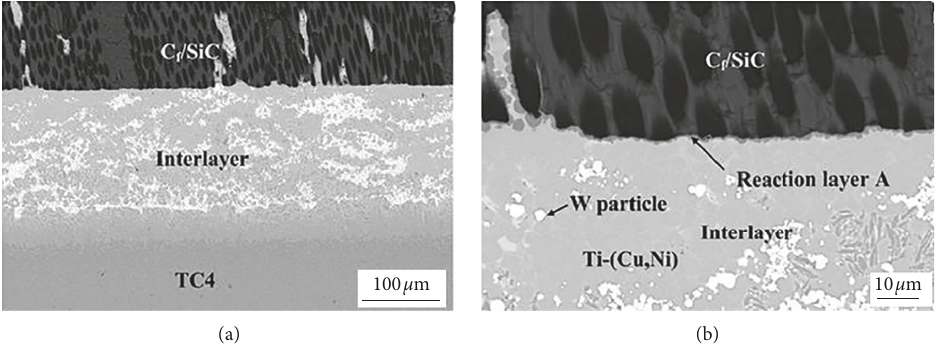
Figure 9: BSE images of the joint: (a) micrograph of the joint; (b) interface between C